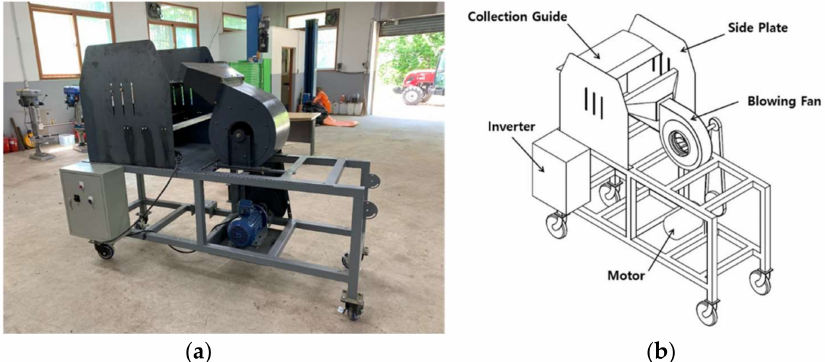
Figure 6. Picture ( a ) and schematic view ( b ) of the experiment bench for a separation